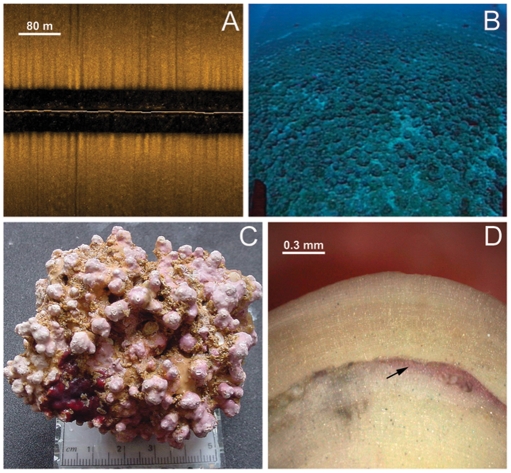
Selected aspects of rhodolith beds and individual rhodoliths.(A) SSS sonogram showing flat and highly reflective bottom typical of rhodolith beds. (B) ROV image showing the typical physiognomy of the rhodolith beds. (C) Individual rhodolith consisting primarily of Lithothamnion crispatum with high proportion of live tissue. (D) Superficial view of a rhodolith section observed via a stereomicroscope, showing the reddish band (arrow) corresponding to the staining performed six months earlier.